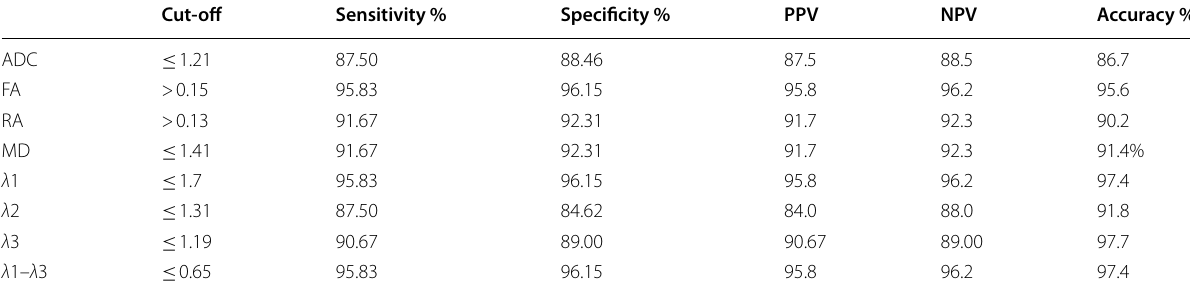
ADC: Apparent diffusion co-efficient. FA, RA: fractional and relative anisotropy, MD: mean diffusivity, λ 1– λ 3: maximum anisotropy index, λ 1, λ 2, λ 3: maximum, middle and minimum eigenvalues, respectively